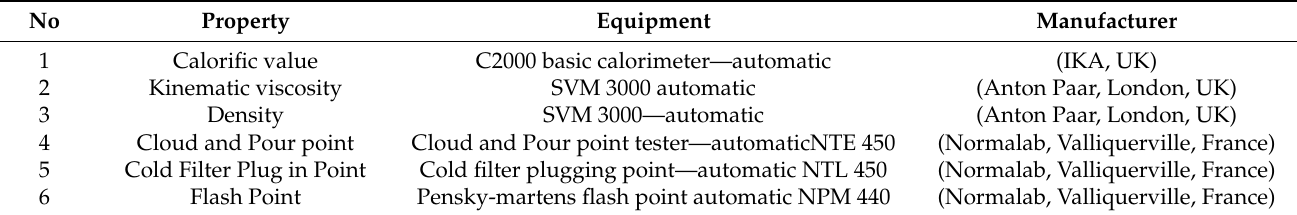
Table 1. Measuring instruments